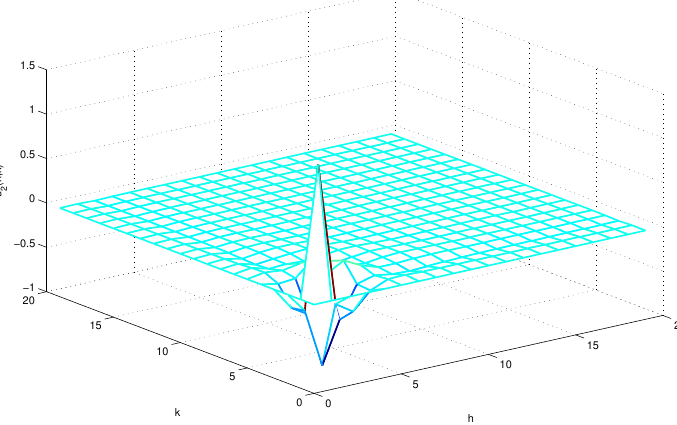
Figure 6. Sliding mode controller component: u 2